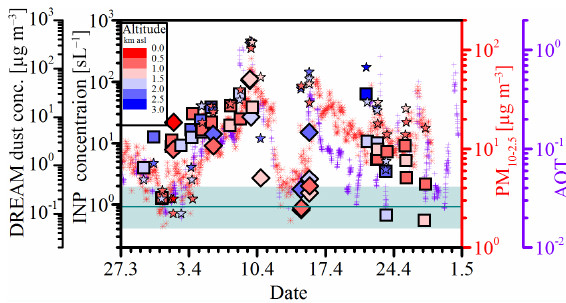
Figure 10. INP concentration ( T =− 30 ◦ C; RH ice = 135.4%) sampled during flights with Skywalker (squares) and Cruiser (di- amonds). The symbols are color-coded by the mean sampling al- titude. The cyan line gives the median INP concentration of 33 FRIDGE measurements from this campaign at ground level at CAO (532ma.s.l.); the shaded area shows the interquartile range. The stars represent DREAM output of the dust mass concentration. The dust proxies PM and AOT (P. Goloumb, personal communication, 2016) are indicated in red and